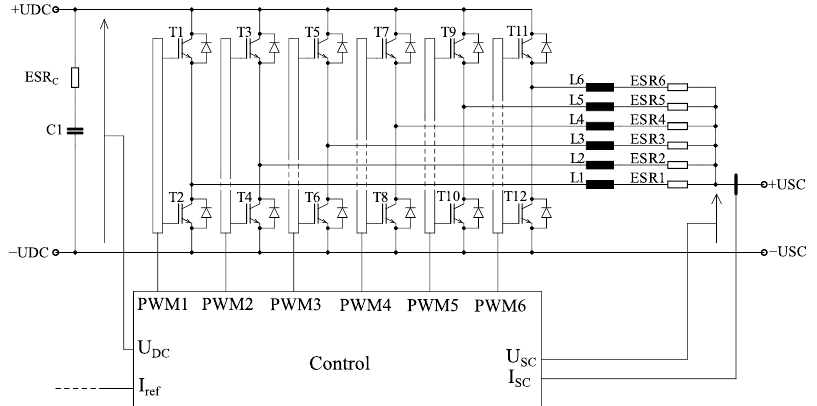
Figure 9. Schematic of a six-phase interleaved buck/boost DC/DC